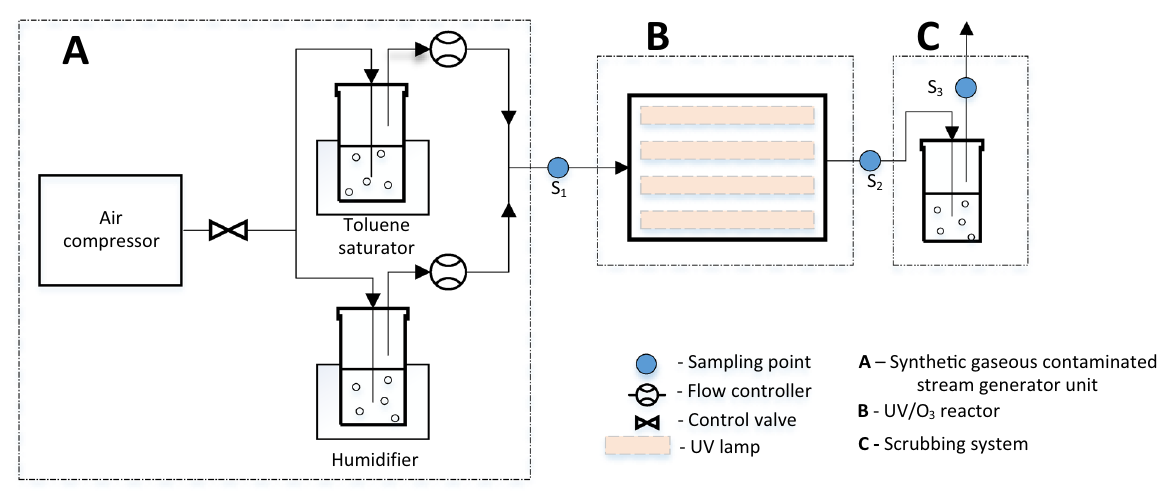
Figure 6. Scheme of the experimental